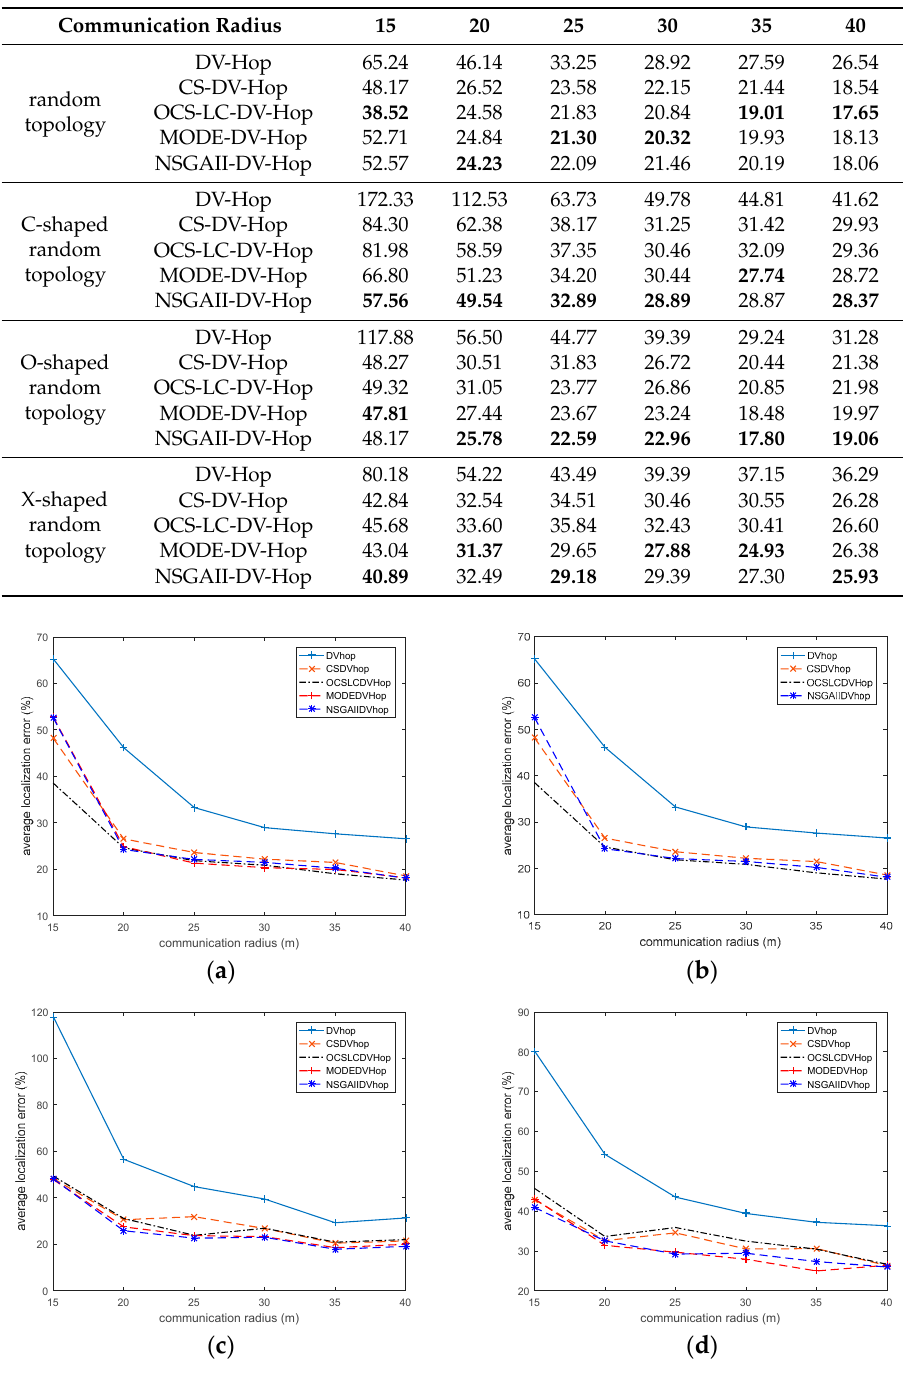
Figure 9. The ALE of four network topologies in different communication radius. ( a ) The random topology; ( b ) The C-shaped random topology; ( c ) The O-shaped random topology; ( d ) The X-shaped random topology.